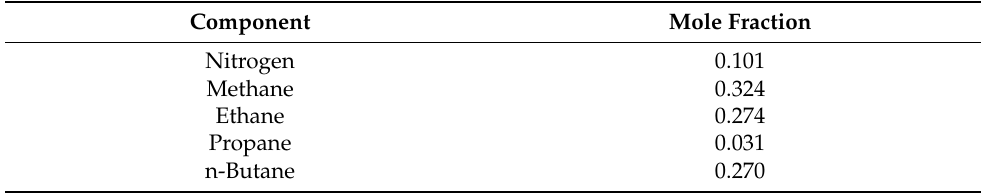
Table 3. Validation case MR composition.